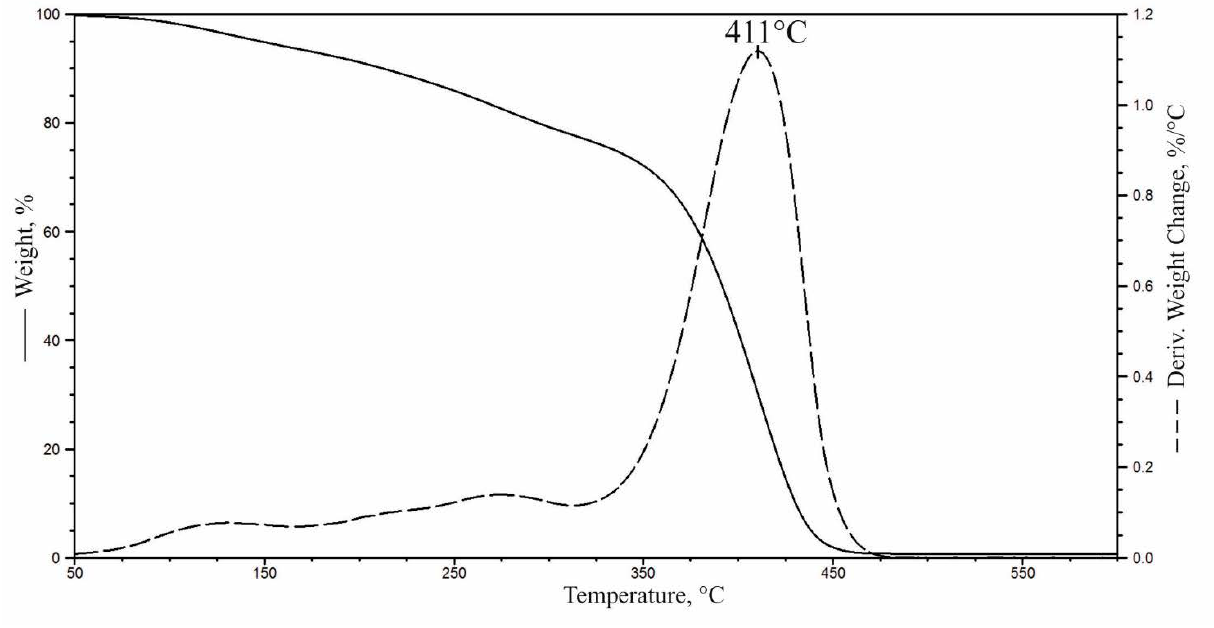
Figure 12. TG and DTG thermograms of the rapeseed oil-based polyol. Table 4. The results of the thermogravimetric